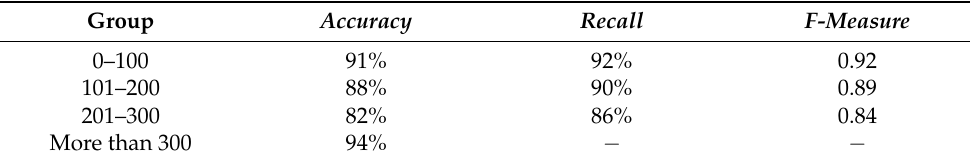
Table 3. Accuracy , Recall and F-measure results discriminated into three groups.